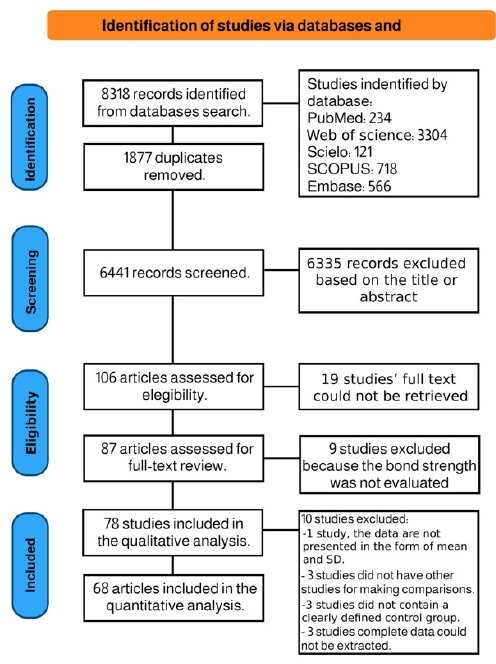
Figure 1. Prisma flowchart according to PRISMA